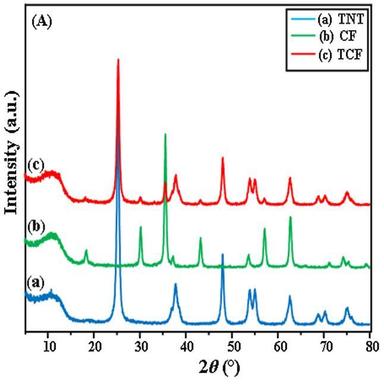
(a) XRPD diffraction patterns of the novel photocatalysts; (b) Rietveld refinement of the TCF nanocomposites. Overall goodness of fit: χ2 = 2.32.